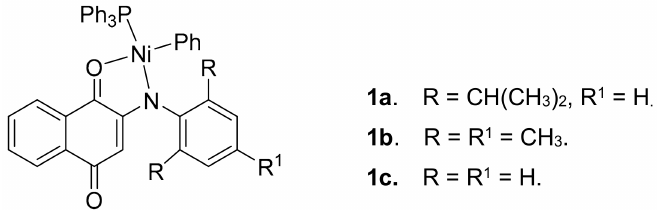
Figure 1. Anilinonaphthoquinone-ligated nickel complexes used in this